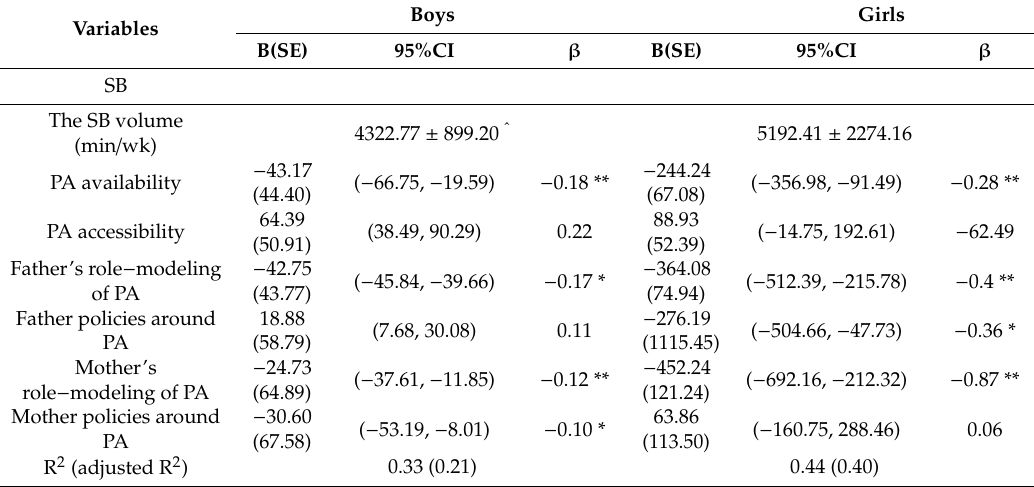
Table 2. The association between home-based environment and adolescents’ weekly physical activity in di ff erent